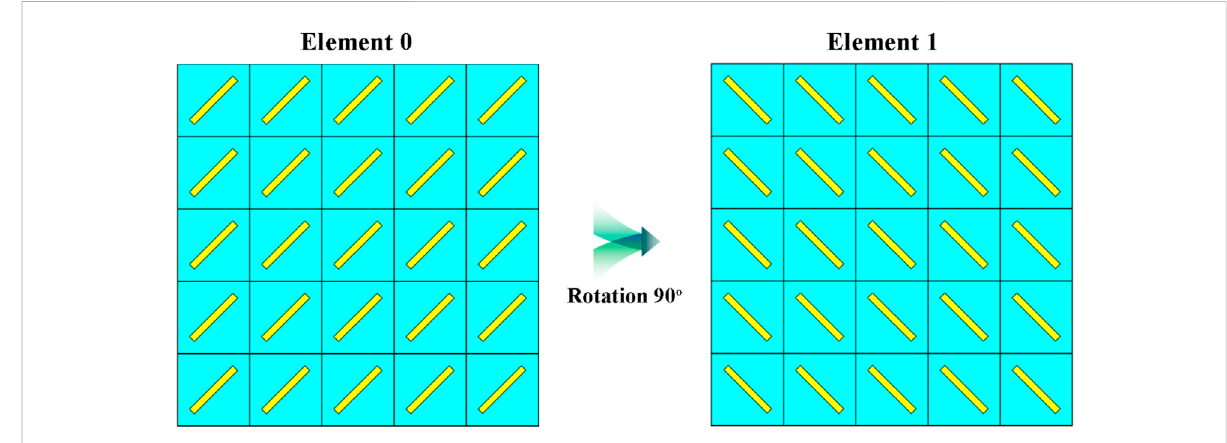
FIGURE 5 Elements of the metasurface element 0 and element